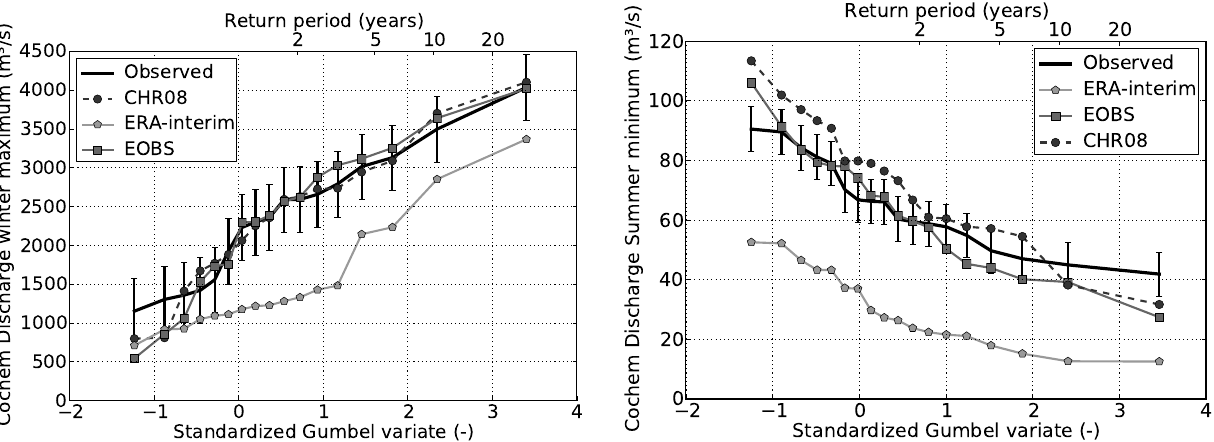
Fig. 7. Gumbel plot for CHR08, E-OBS, ERA-Int and observed winter maximum (left panel) and summer minimum (right panel) discharges and the 95% confidence interval for the observed discharges at Cochem for the period